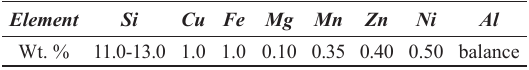
Table 2. Composition of the DC 500 resin (wt.%) (according to the manufacturer). Multi-functional Element acrylic monomers